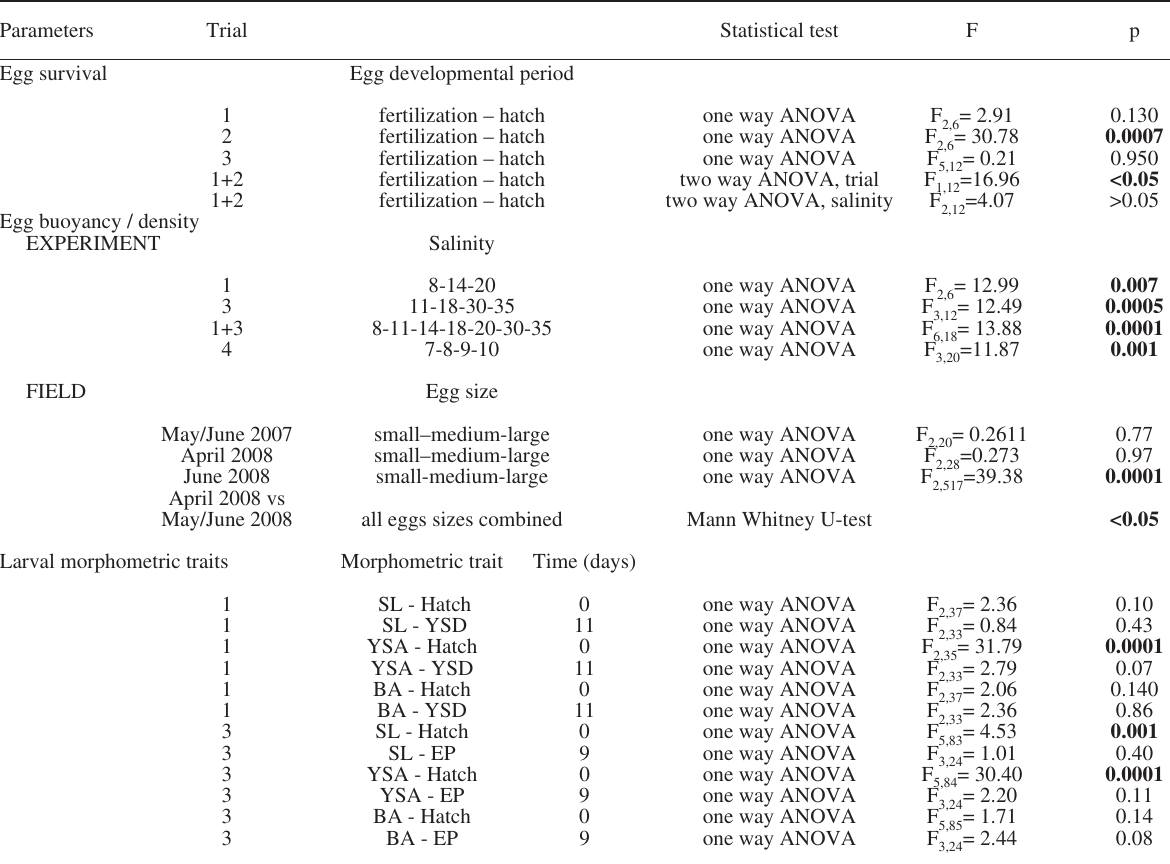
T ABLE 4. – Statistical results of the analysis of egg survival, egg buoyancy from experimental and field data and morphometric traits of sprat. Relative egg sizes refer to unpreserved, live eggs and were between 1.26 and 1.38 mm for small, 1.39 and 1.51 mm for medium and 1.52 and 1.64 mm for large eggs. Larval morphometric traits are measured at three important ontogenetic events (hatch, eye pigmentation (EP) and yolk sac depletion (YSD)). SL is standard length, YSA refers to yolk sac area and BA describes larval body area excluding larval finfolds. Significant differences between salinities are contrasted in bold